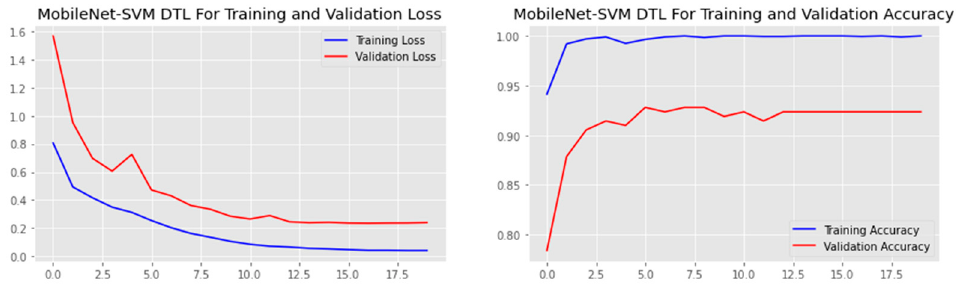
Figure 4. Accuracy and loss graph of the MobileNet-SVM model .